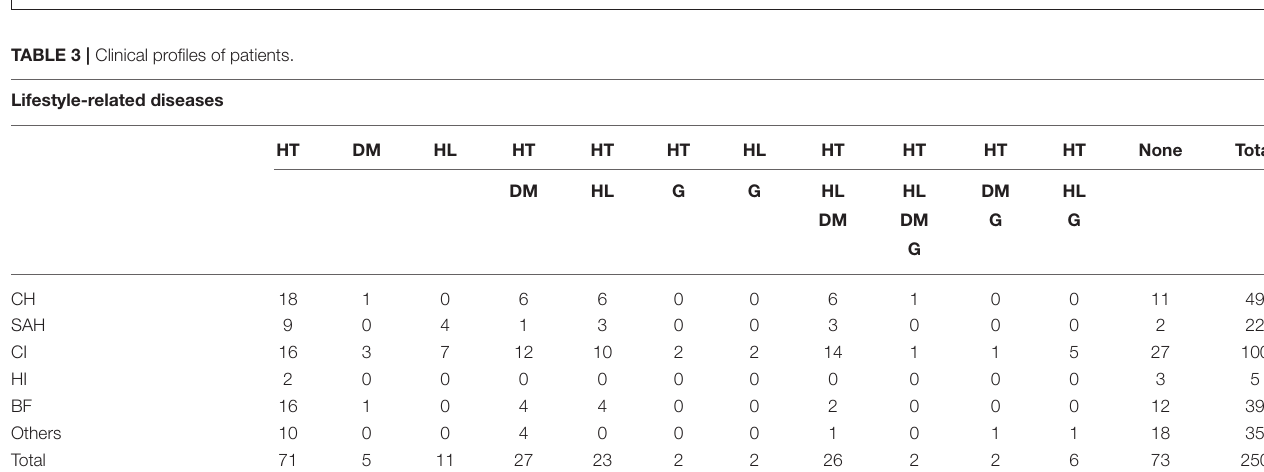
FIGURE 2 | MMSE score distribution: 22.9 ± 6.1 (mean ± SD).